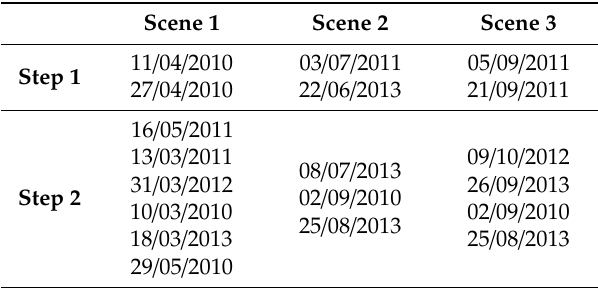
Table 2. List of composite